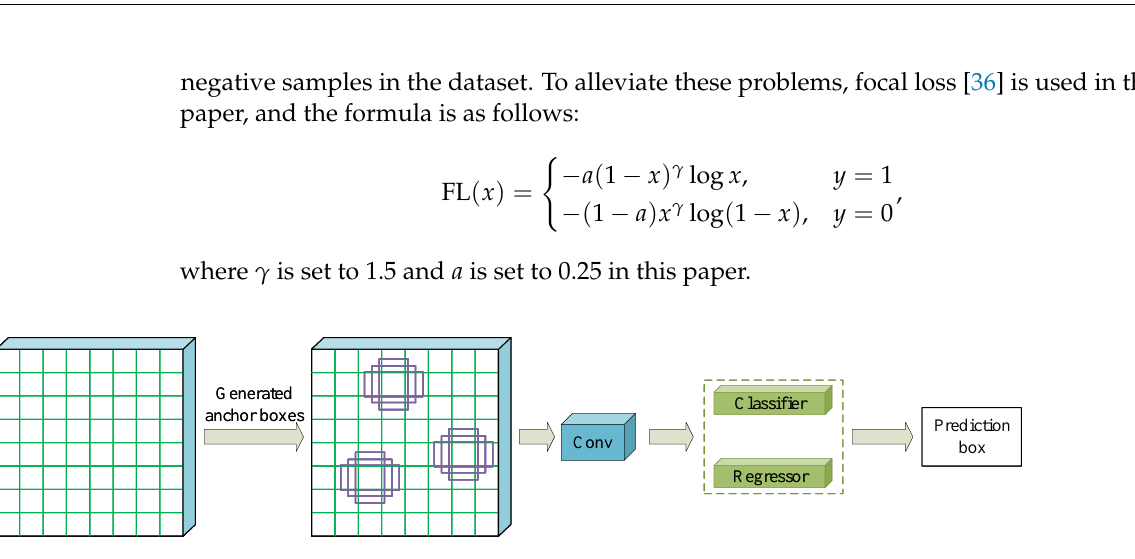
Figure 7. The schematic diagram of prediction box generation, where purple boxes represent anchors.